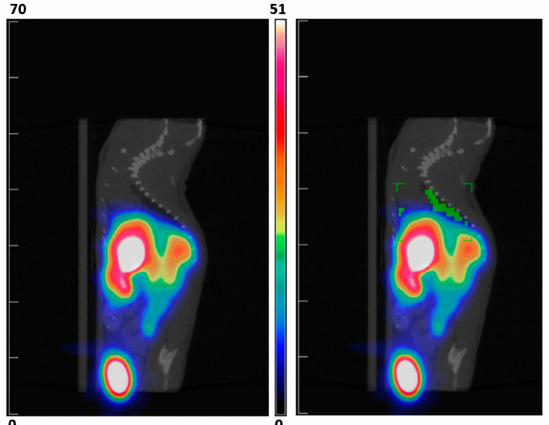
Figure 10. In vivo [ 18 F] 45 microPET / CT images of a mouse exposed to cigarette smoke (CS) shown in a sagittal view. The right view indicates the ROIs (Regions Of Interest) drawn in the lung. The microPET images correspond to the sum of all the frames from 12 to 90 min p.i. of [ 18 F] 45 . Reprinted with permission from [107] Copyright © World Molecular Imaging Society